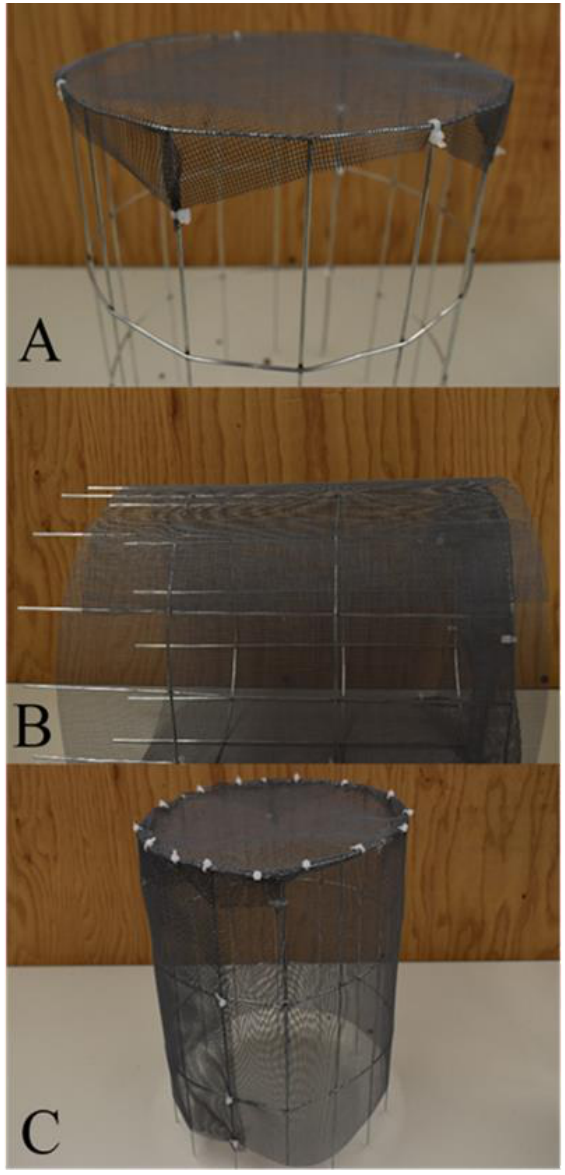
Figure 4. Attachment of screen door mesh to internal frame structure. (A) Mesh attached to the top of exclosure, (B) Mesh surrounding the side of exclosure, showing length needed for attachment, (C) Mesh attached securely to